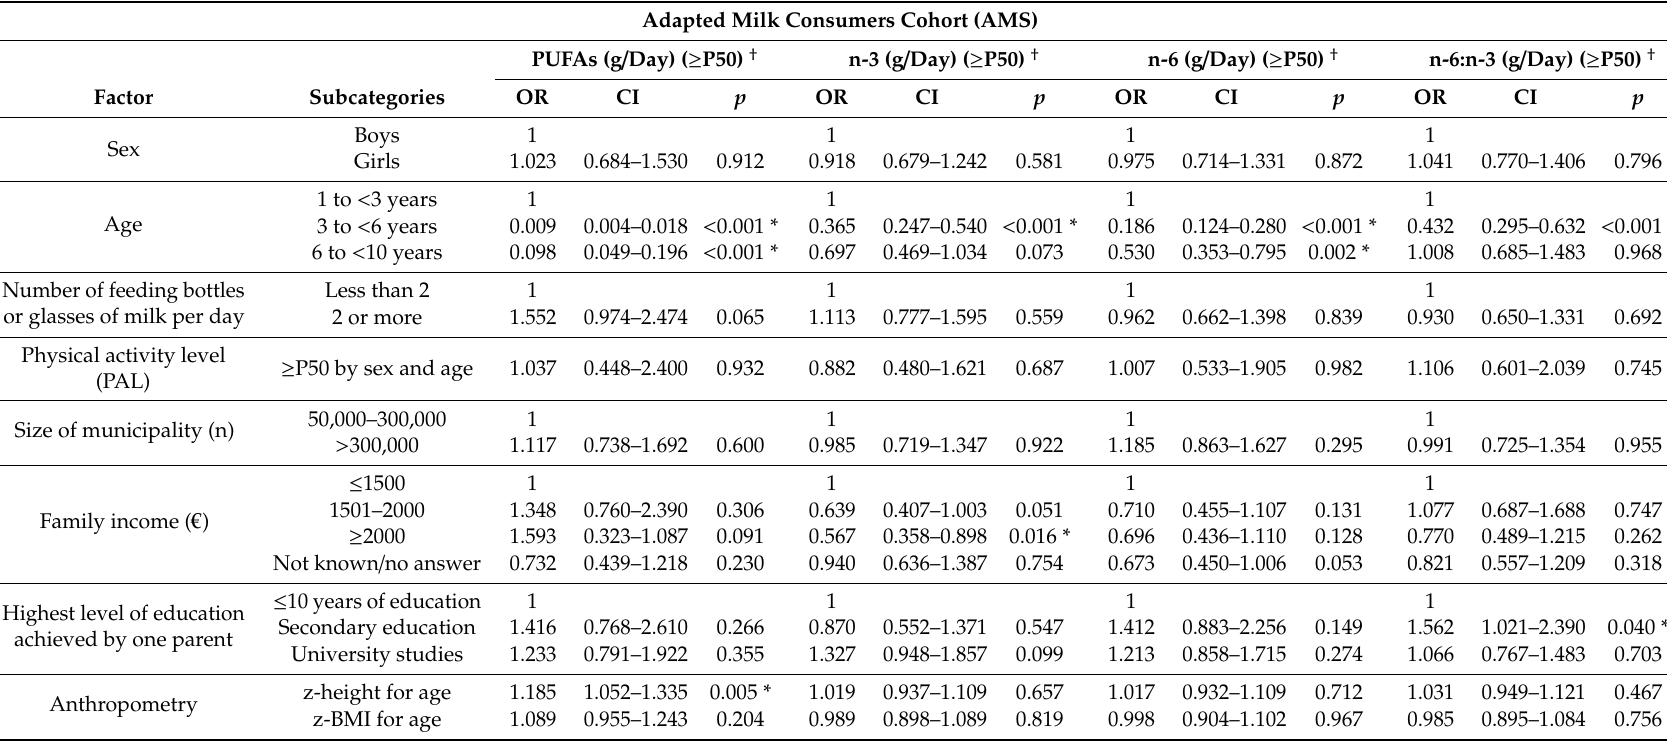
Table 12. Odds ratios and 95% confidence intervals for intake equal to or higher than the median of n-3 fatty acids, n-6 fatty acids, and n-6:n-3 ratio relative to family and personal factors in adapted milk consumers cohort of Nutritional Study in the Spanish Pediatric Population (EsNuPI) ( n =